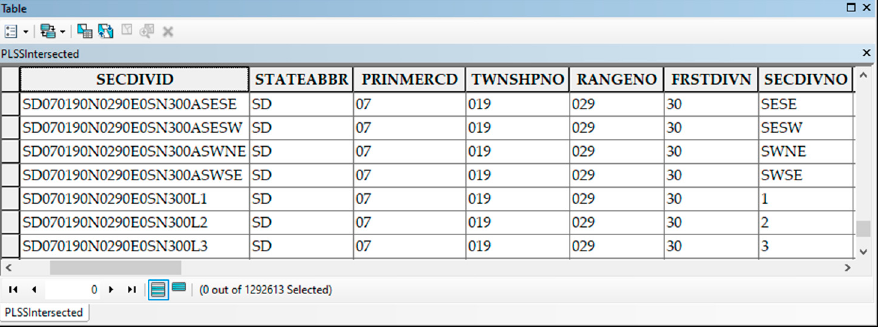
Figure 8. PLSS attribute table viewed in ArcGIS. SECDIVID (PLSS second division identification) field needs only slight modification to match the UID from the allotment ledger spreadsheet.